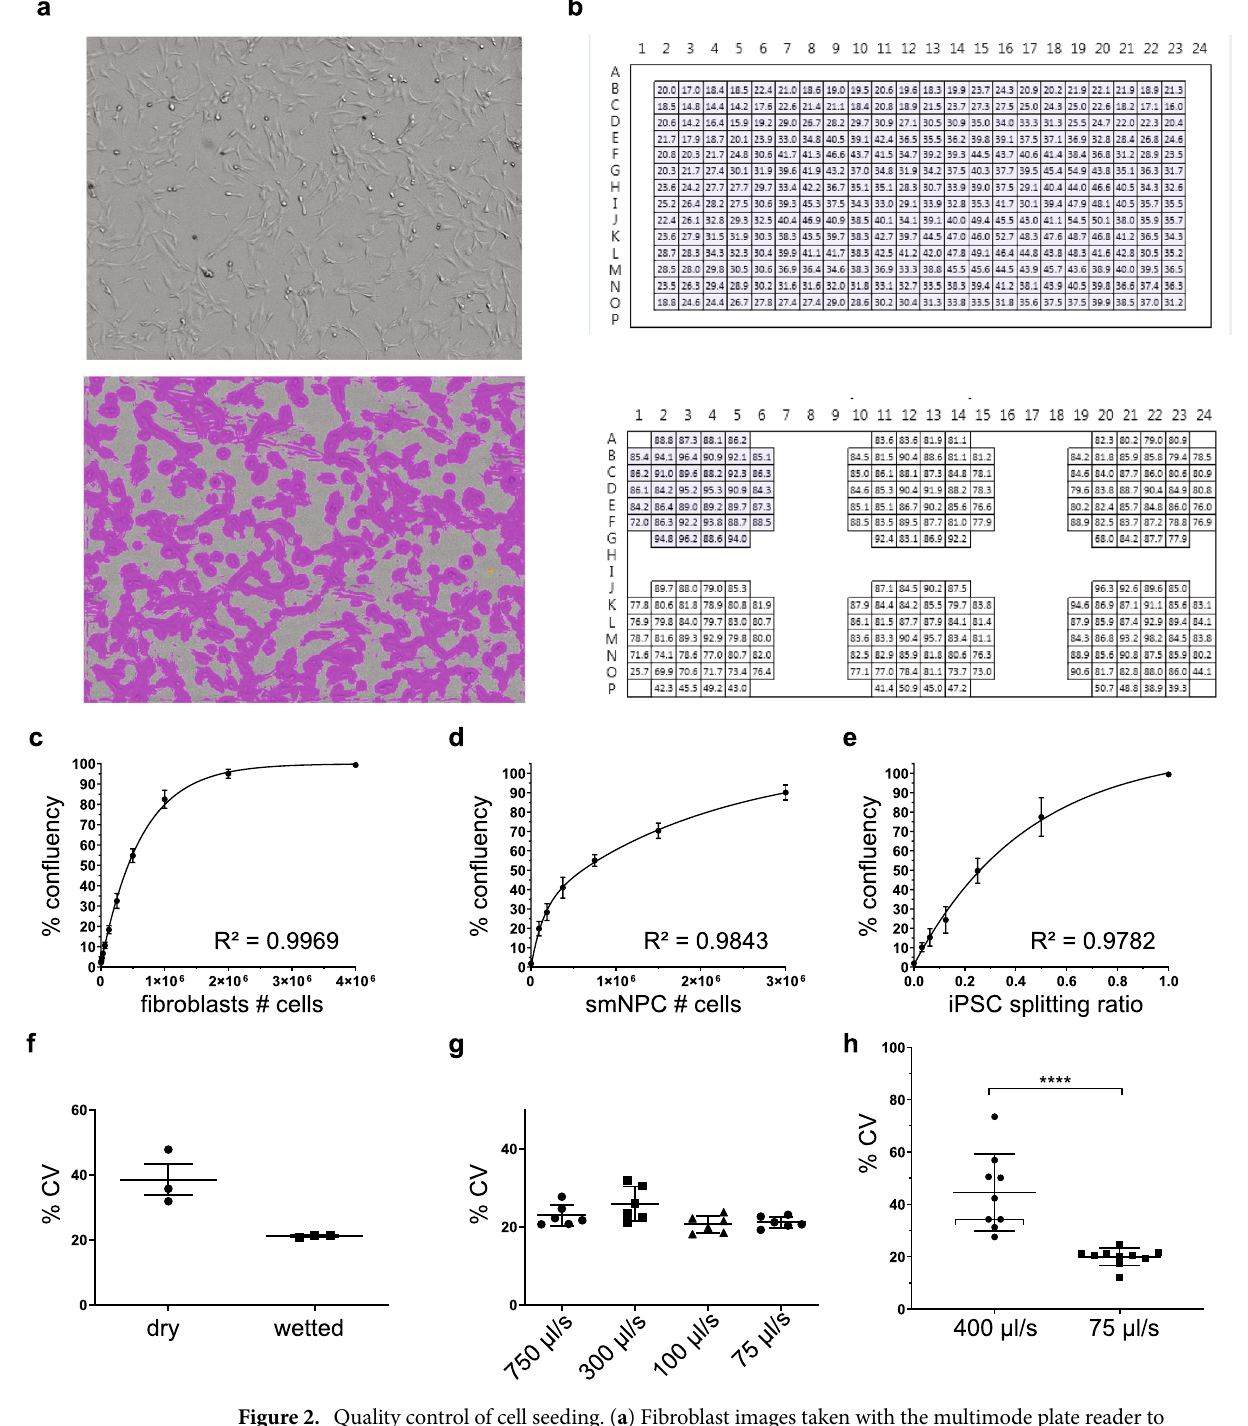
Figure 2. Quality control of cell seeding. ( a ) Fibroblast images taken with the multimode plate reader to determine confluency without (top) and with (bottom) mask highlighting areas covered by cells. ( b ) Acquisition mask for confluency measurement of a 1-well plate (top) and a 6-well plate (bottom). Each field represents a field of acquisition and numbers in the fields indicate percentage of confluency. ( c – e ) Non-linear curve fitting on confluency reads of serially diluted or split fibroblasts (n = 3) ( c ), smNPC (n = 7) ( d ), and iPSC (n = 4) ( e ). ( f ) Measurement of CV after dispensing test with fibroblast into dry or pre-wetted 6-wells. n = 3. ( g ) Measurement of CV after testing dispensing speeds with fibroblast in 6-wells. n = 6 ( h ) Measurement of CV after testing dispensing speeds with iPSC in 6-wells. n = 9, statistical test used: Mann–Whitney